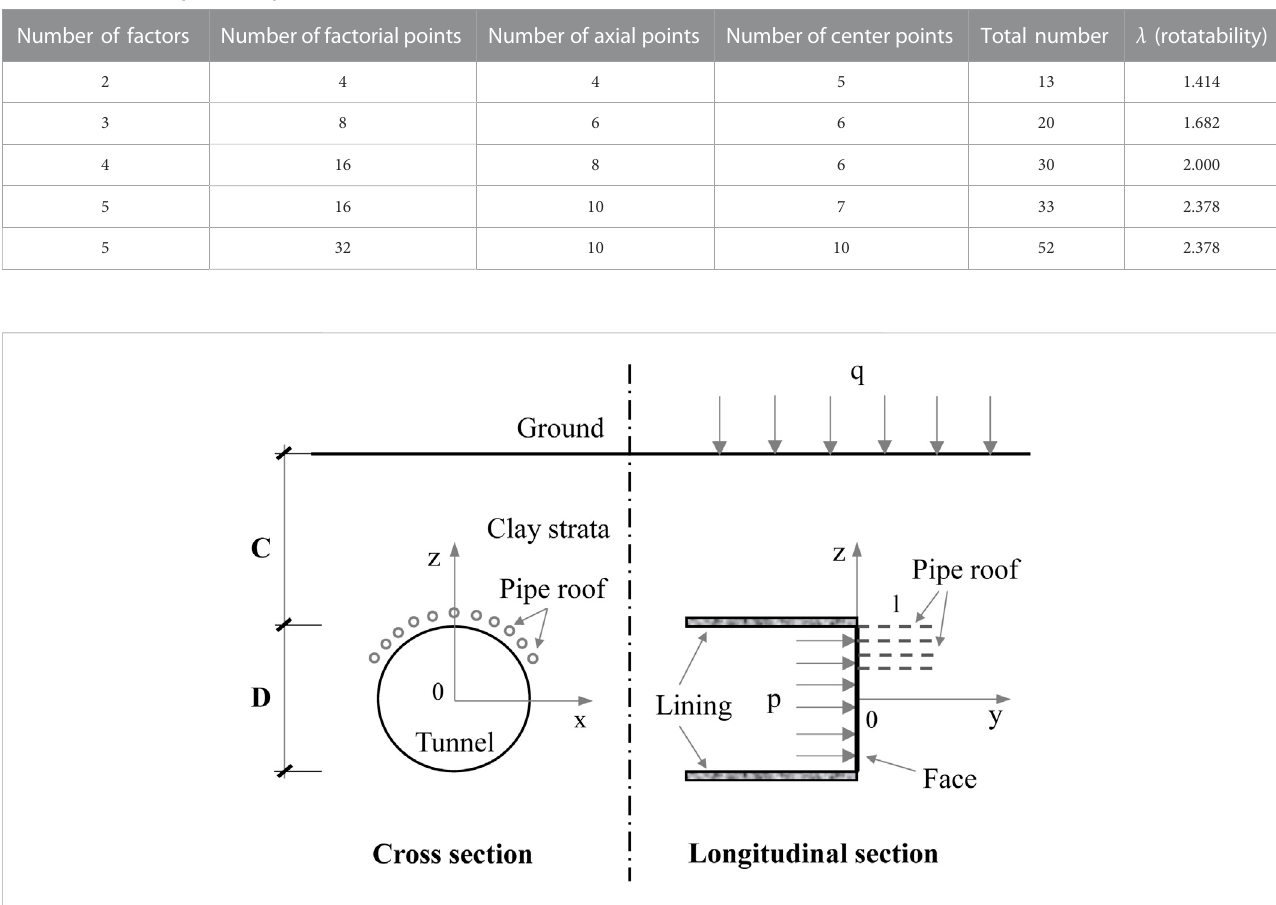
TABLE 1 Number of experimental points of the CCD (Number of factors < 6).